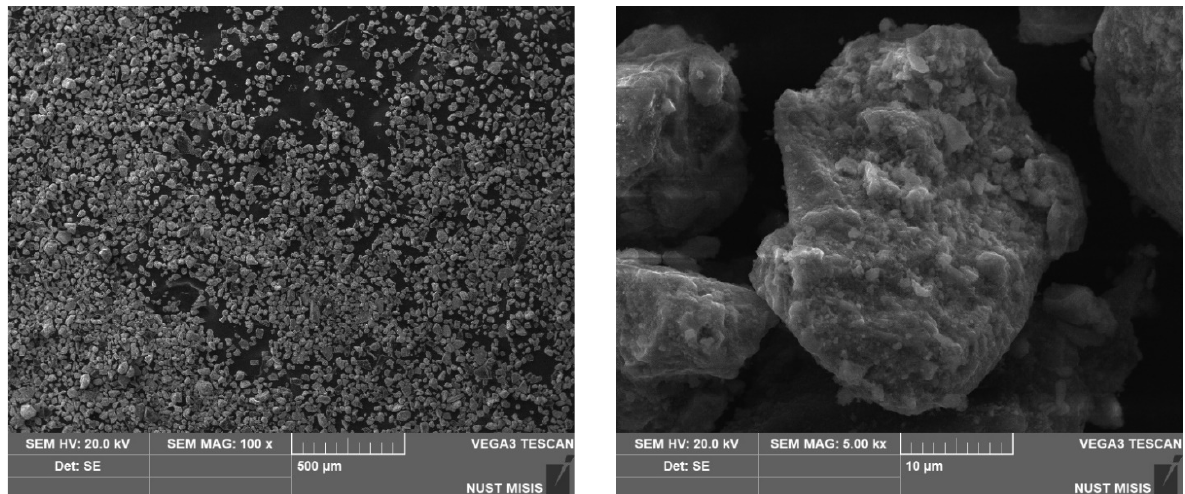
Figure 2. Micrographs of blast ‐ furnace sludge powder.